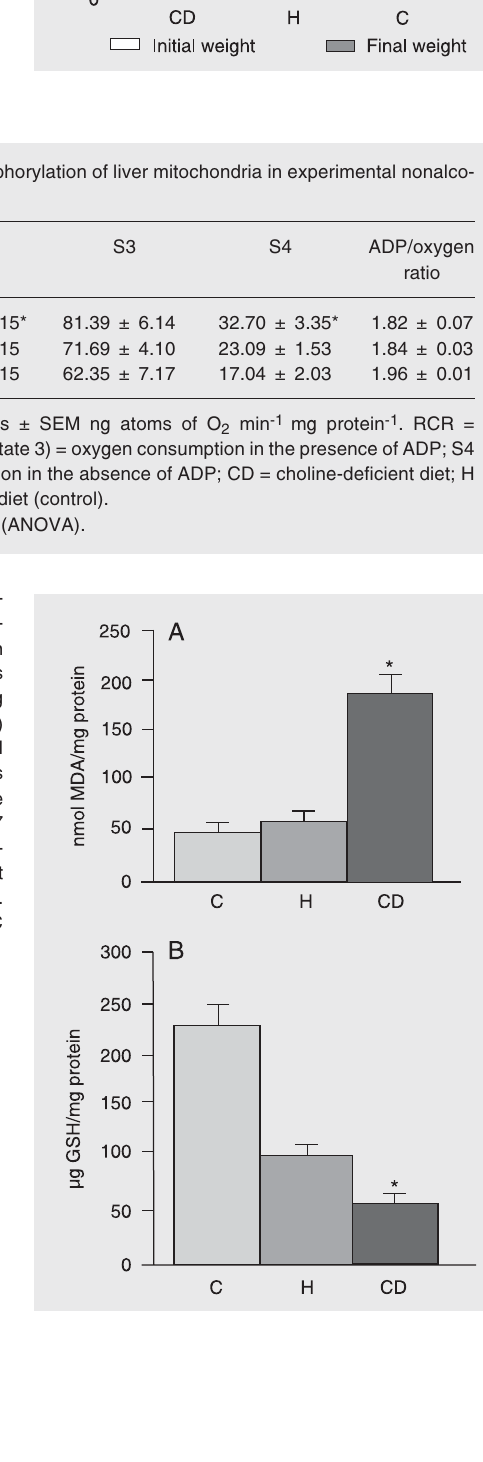
Figure 1. Initial and final weight of the animals. Data are reported as means ± SEM for 7 rats in each group as a function of di- ets. CD = choline-deficient diet; H = high-fat diet enriched with PUFAs- ω -3; C = standard diet (control).